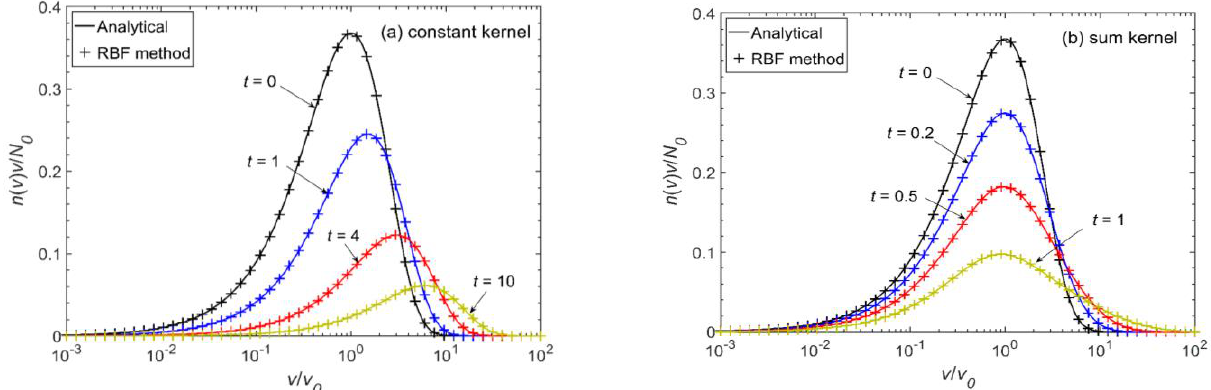
Figure 1. Comparison of the RBF method and the analytical solution for predicting the temporal evolution of particle size distributions: ( a ) constant kernel coagulation; ( b ) sum kernel coagulation. The solid lines are predictions obtained using the analytical solutions and the plus symbols are predictions obtained using the RBF method.